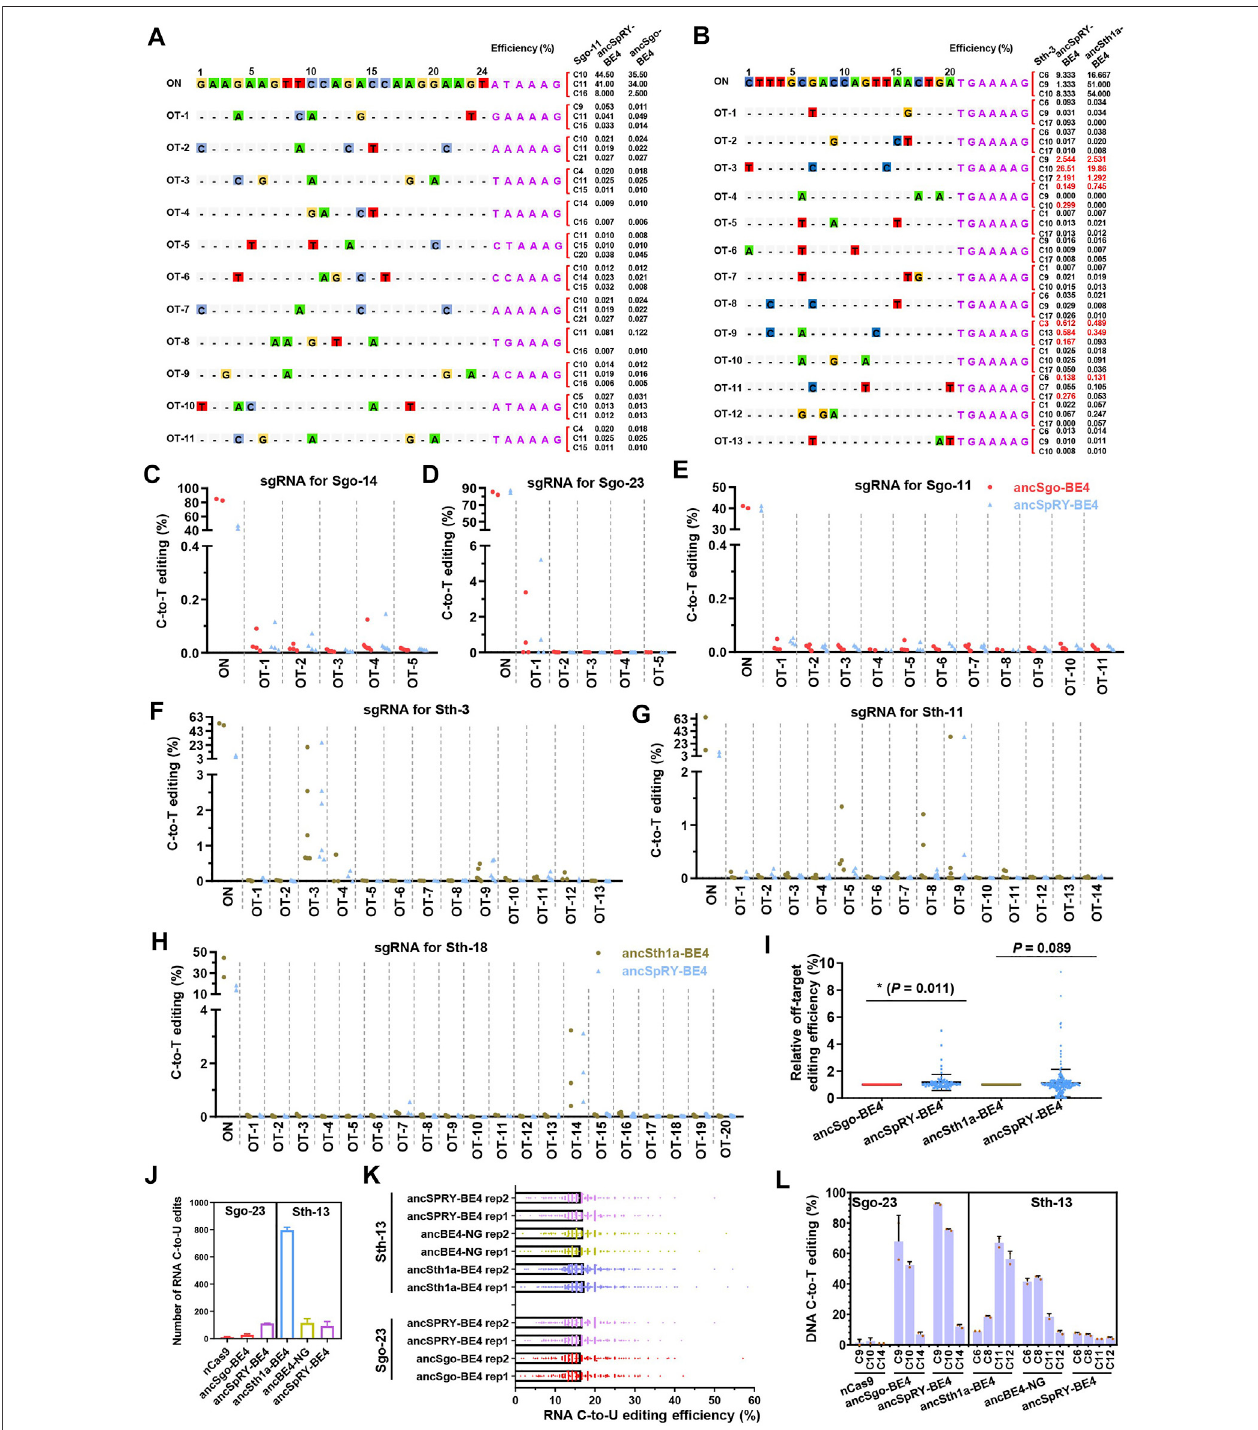
FIGURE 6 | Characterization of DNA or RNA off-targeting features induced by ancSgo-BE4 and ancSth1a-BE4. (A) The on-targeting (ON) and off-targeting (OT) C-to-T conversion ratesinducedbyancSgo-BE4and ancSpRY-BE4werepresentedfortwoorthreecytosineswiththehighestef fi cienciesattargetsiteSgo-13. Atotal of 11 off-target sites were detected. (B) The on-targeting (ON) and off-targeting (OT) C-to-T conversion rates induced by anSth1a-BE4 and ancSpRY-BE4 were presented for two or three cytosines with the highest ef fi ciencies at target site Sth-3. A total of 13 off-target sites were detected. (C – E) Comparison of C-to-T off-targetingef fi cienciesattheon-targetsiteSgo-14 (C) ,Sgo-23 (D) ,andSgo-11 (E) betweenancSgo-BE4andancSpRY-BE4inHEK293Tcells. (F – H) Comparisonof C-to-T off-targeting ef fi ciencies at the on-targetsite Sth-3 (F) , Sth-11 (G) , and Sth-18 (H) between ancSth1a-BE4 and ancSpRY-BE4 in HEK293T cells. Comparison of